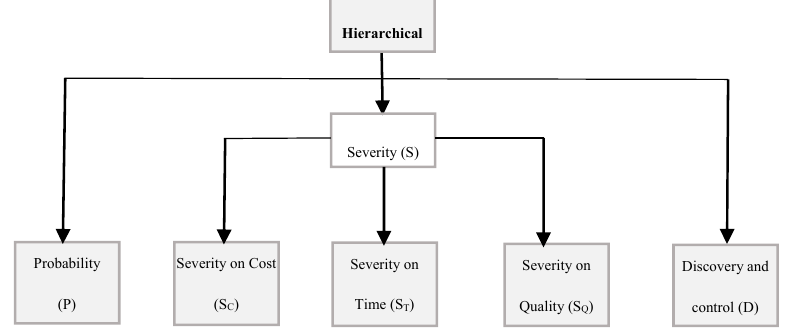
Figure 4. Hierarchical structure of risk assessment factors. Source: Authors’ elaboration. Table 1. Fuzzy spectrum for comparison of risk assessment factors.